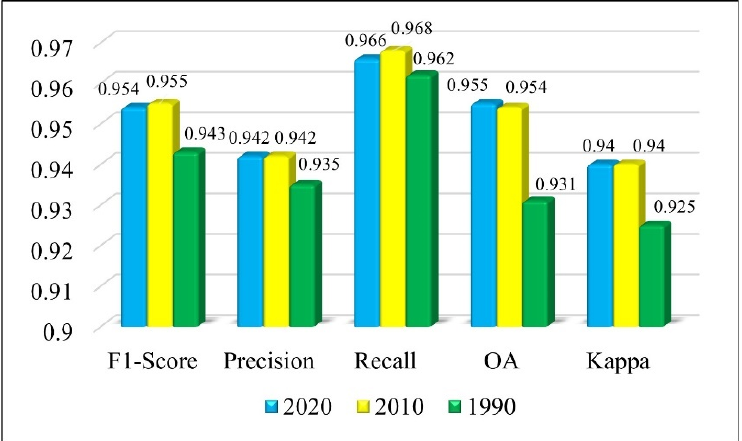
Figure 13. The extraction accuracy of coniferous forests by using U 2 ‐ Net in three periods (1990, 2010 and 2020).